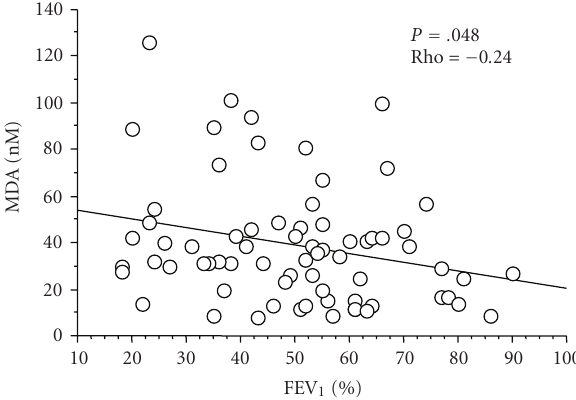
Figure 4: Correlation between FEV 1 , % predicted, and malondi- aldehyde (MDA) concentrations in COPD subjects (Spearman rank correlation